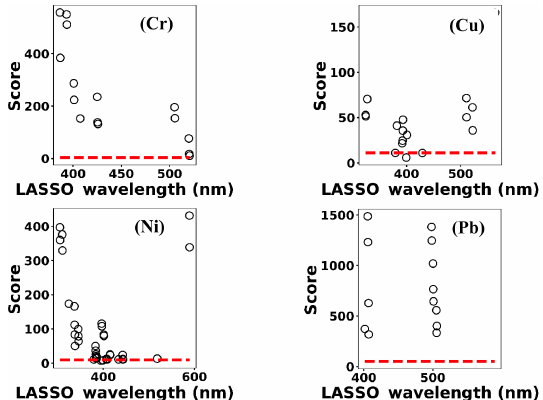
Figure 13. Model scores defined by Eq. (3) for Cr, Cu, Ni, and Pb. Circles indicate univariate models scores and dashed lines corre- spond to LASSO